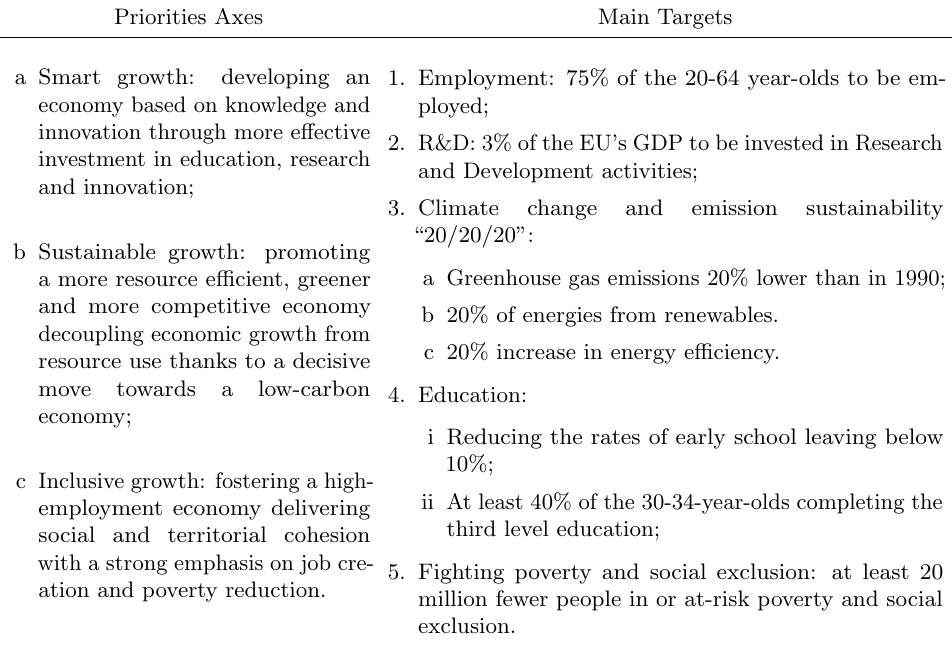
Table 1: The Europe 2020 Strategy: Axes and Targets